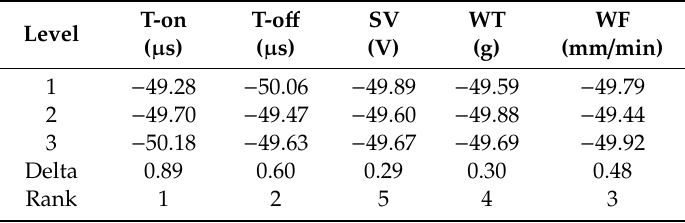
Table 8. S / N ratio analysis of IFR (smaller is better).